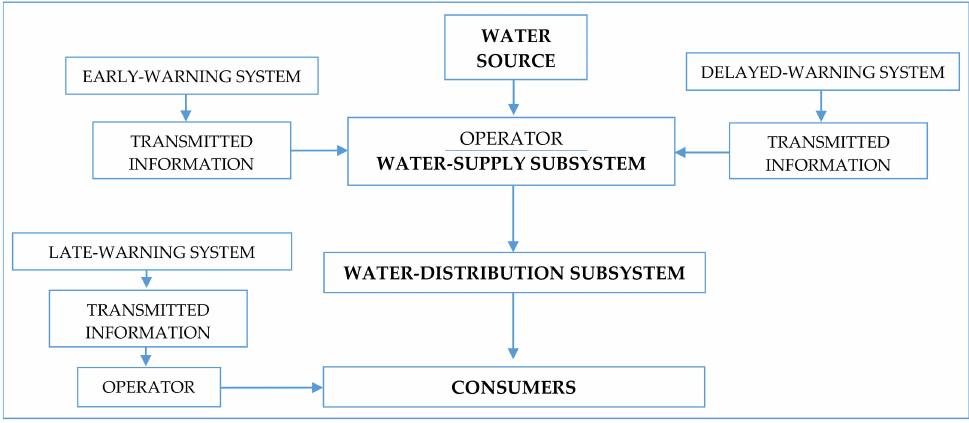
Figure 1. Functional diagram for early-, delayed- and late-warning